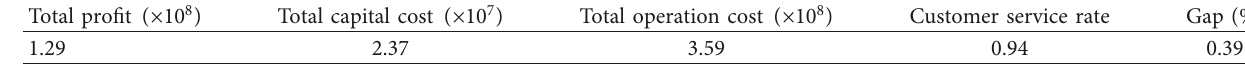
Table 5: Performance of the optimal solution.